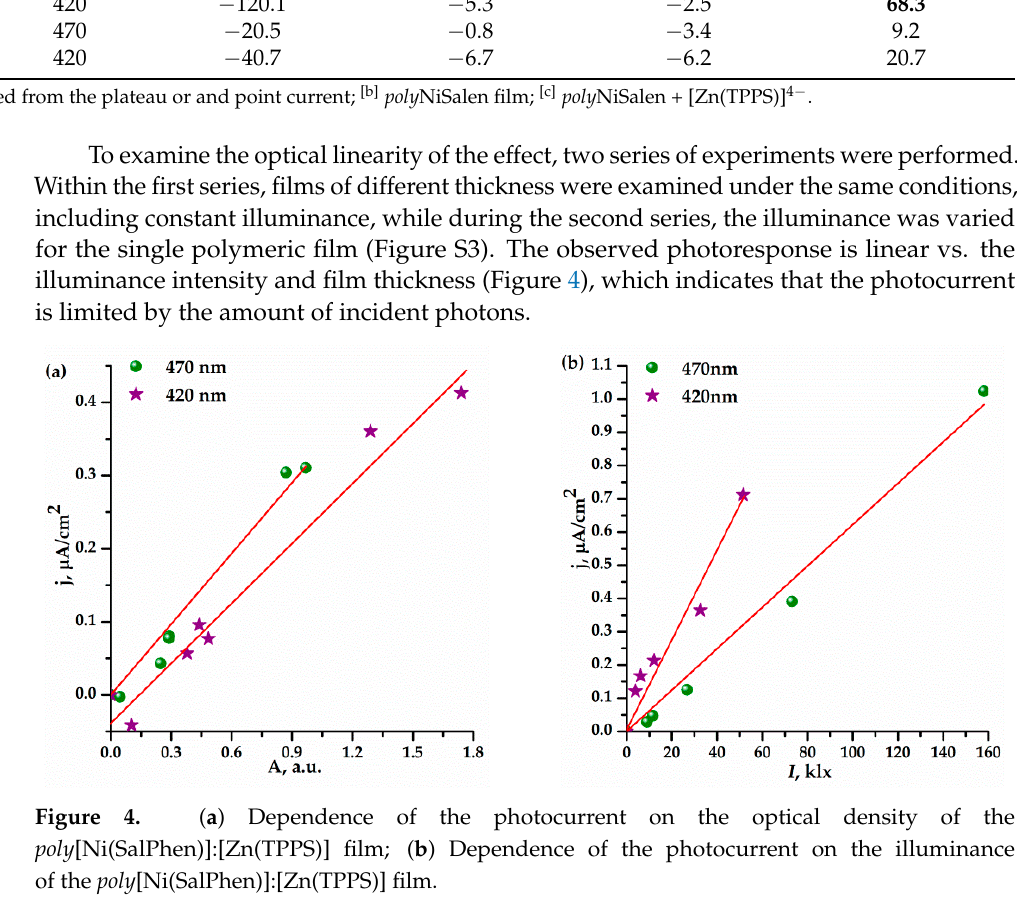
Table 1. Relative light efficiencies of the films.